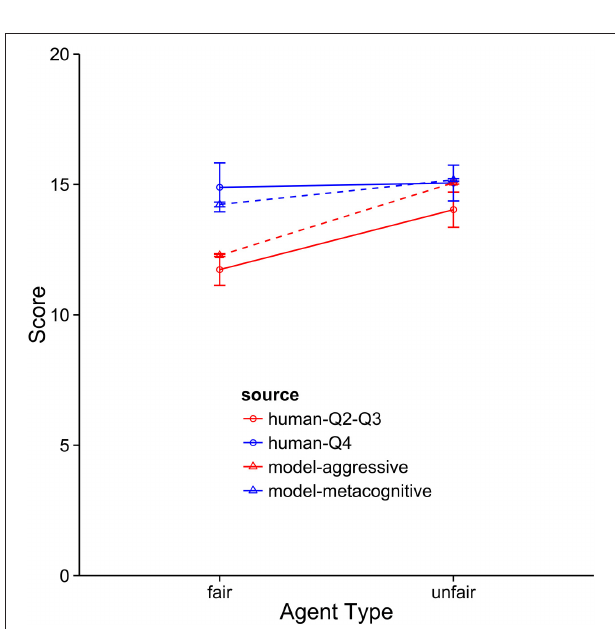
FIGURE 8 | Comparison of the aggressive and metacognitive models to human data with respect to negotiation score. The Y-axis represents raw score per block. Separate lines represent different groups of humans or model